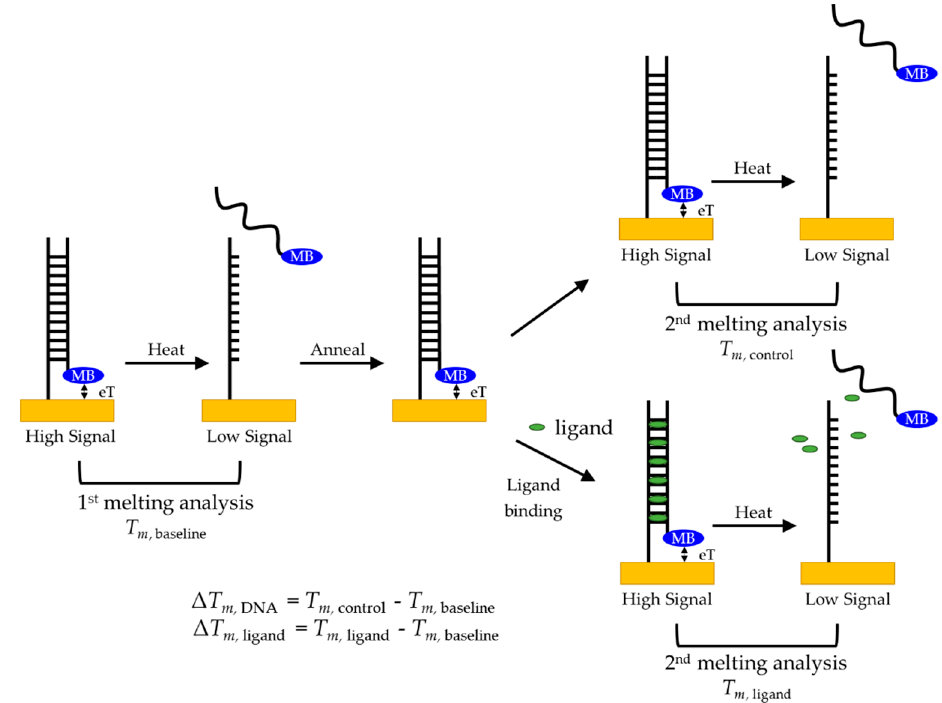
Figure 4. Melting analysis protocol for duplex DNA to probe for ligand-induced stabilization and to minimize measurement variability.